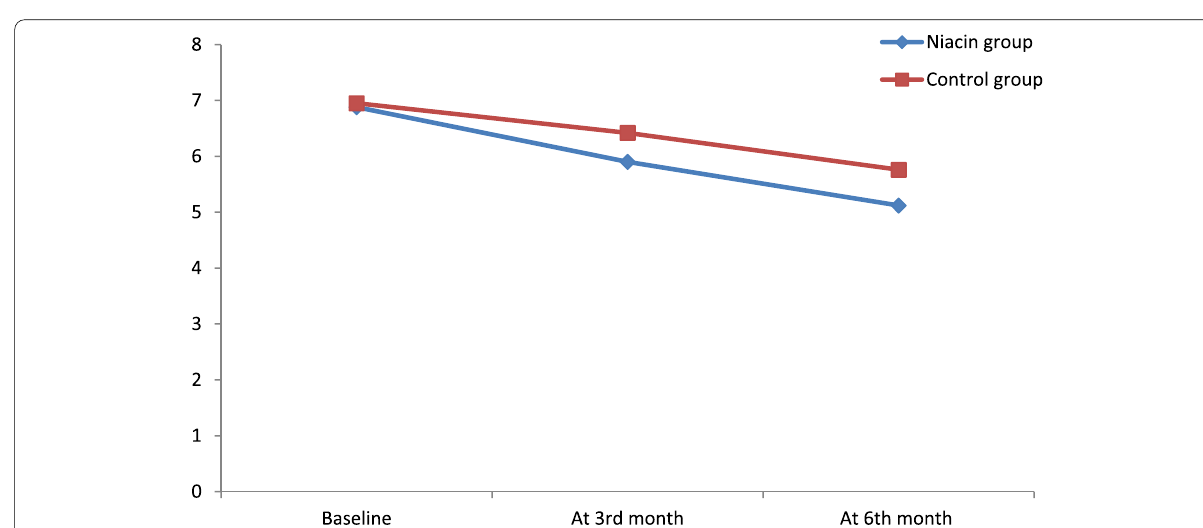
Fig. 9 Changes in level of serum phosphorous in both